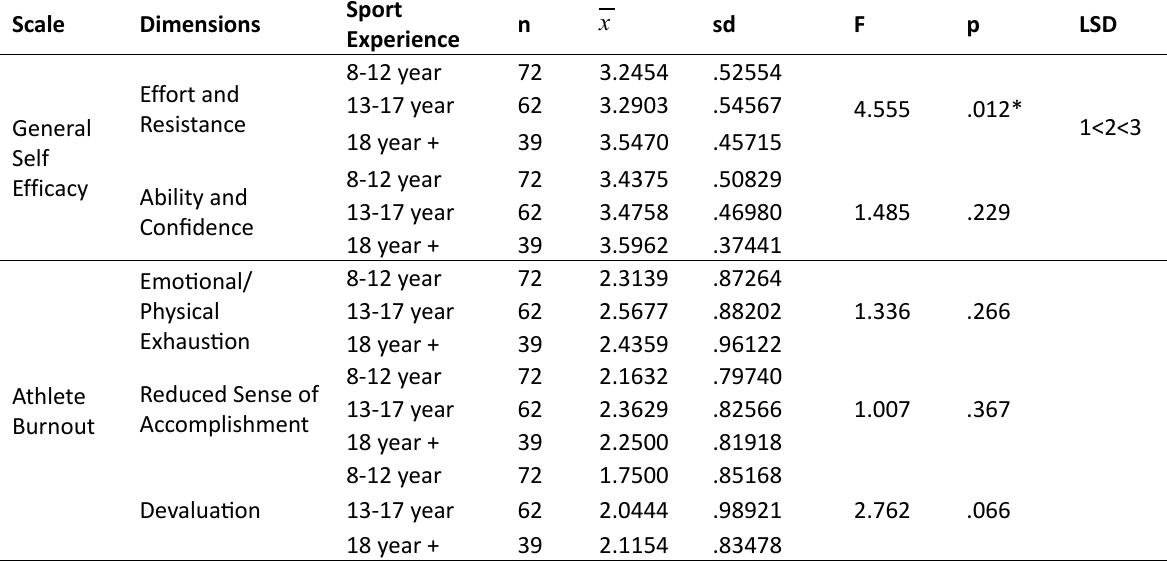
Table 4. Evaluation of general self-efficacy and athlete burnout level by sport experience Scale